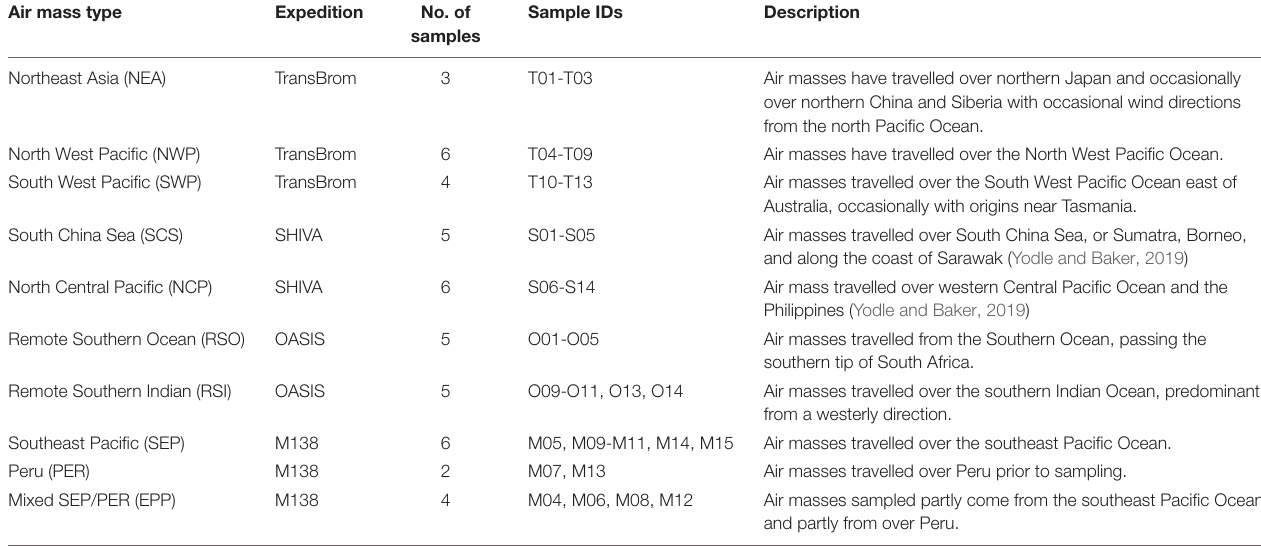
TABLE 3 | Description of air mass types for all